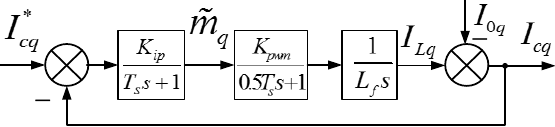
Figure 4. Control structure diagram of the inner current loop.